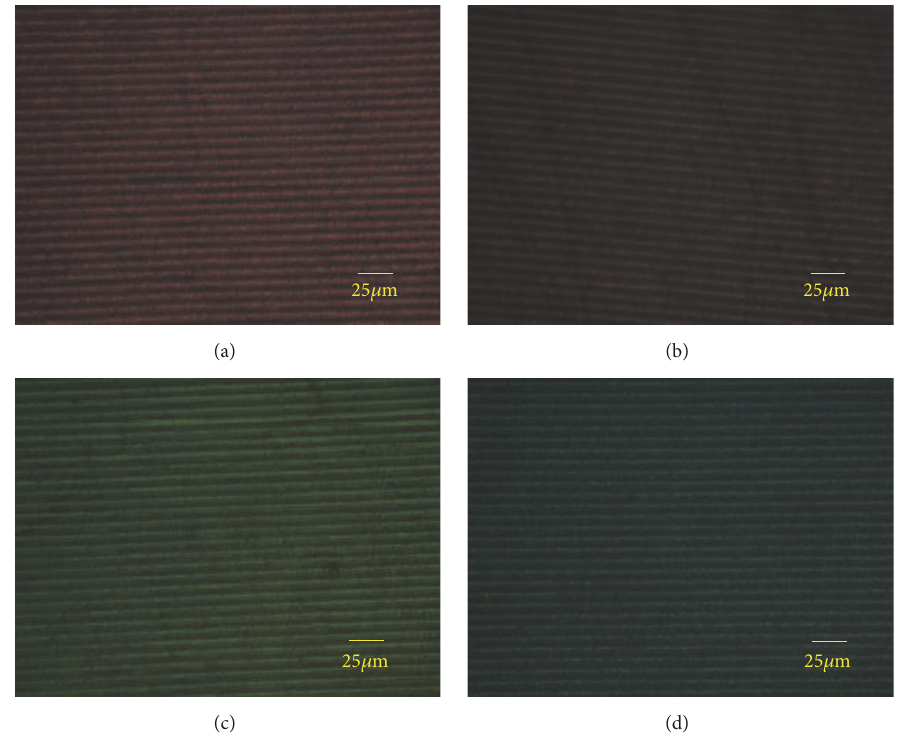
Figure 4: Reflected polarized optical microscopic image of the CLC polymer template gratings refilled with (a) RCLC-red, (b) LCLC-red, (c) RCLC-green, and (d) LCLC-green, respectively. The scale bar is 25 𝜇